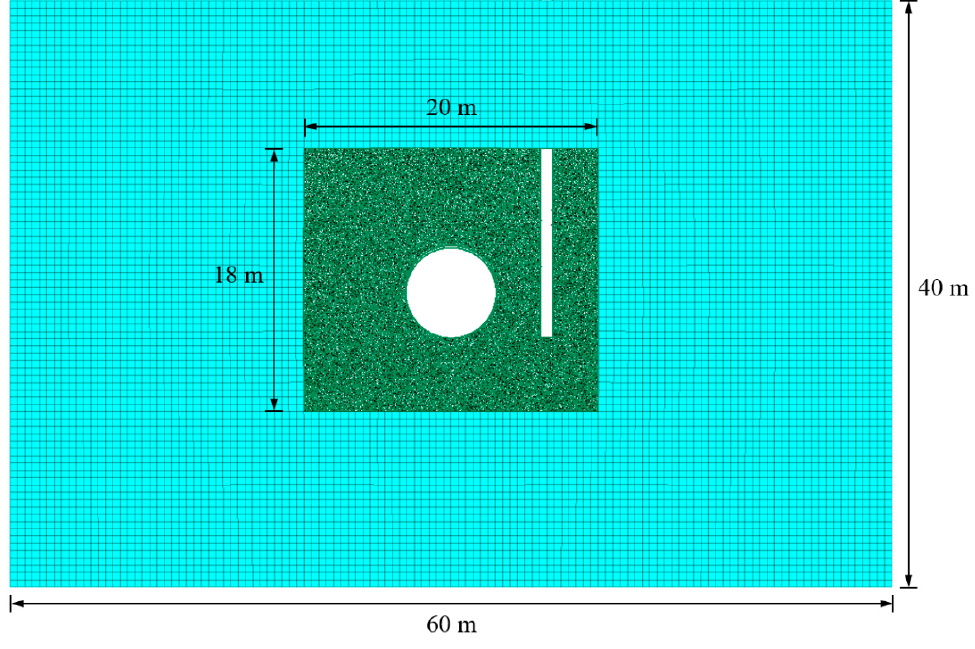
Figure 5. FDM-DEM Coupling Numerical Model. Table 1. Macroscopic and microscopic physical and mechanical parameters of